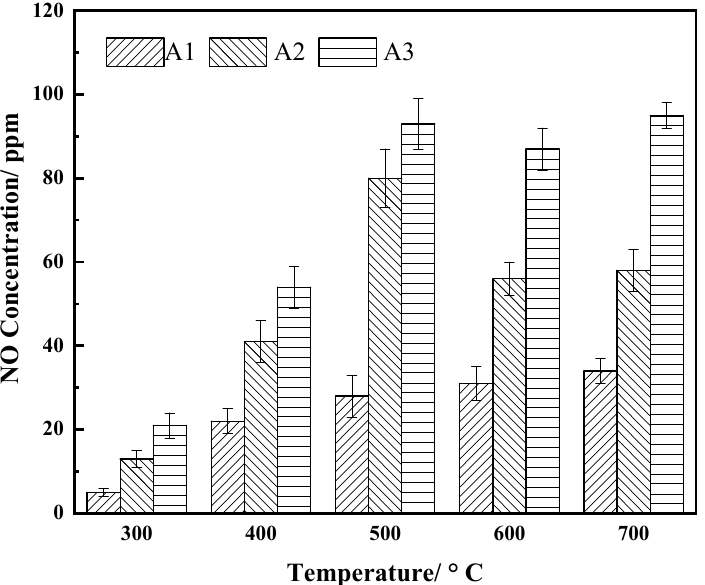
Figure 6. The concentration of NO during thermal desorption of simulated polluted soils under 20% O 2 /N 2 atmosphere at different temperatures. (A1, sample of 1 mL waste oil mixed with 25 g soil; A2, sample of 2 mL waste oil mixed with 25 g soil; A3, sample of 3 mL waste oil mixed with 25 g soil).